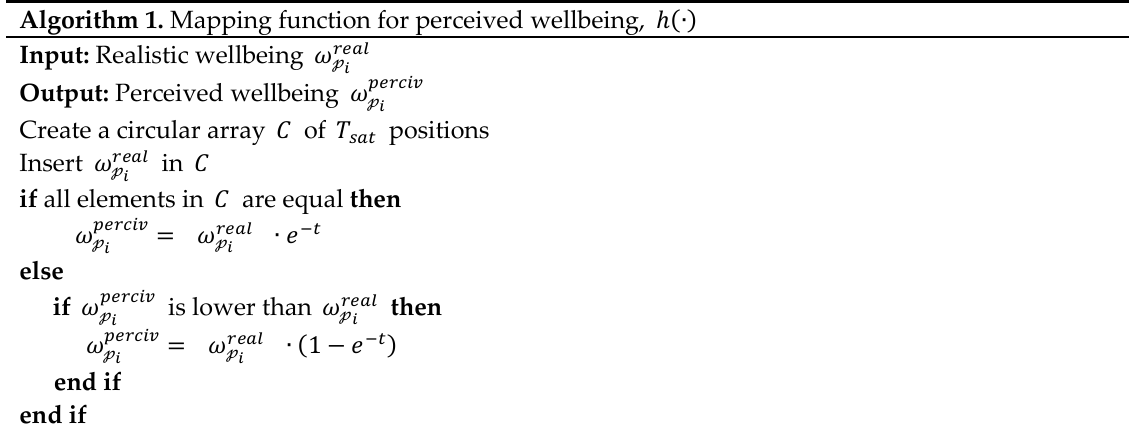
Algorithm 1. Mapping function for perceived wellbeing,